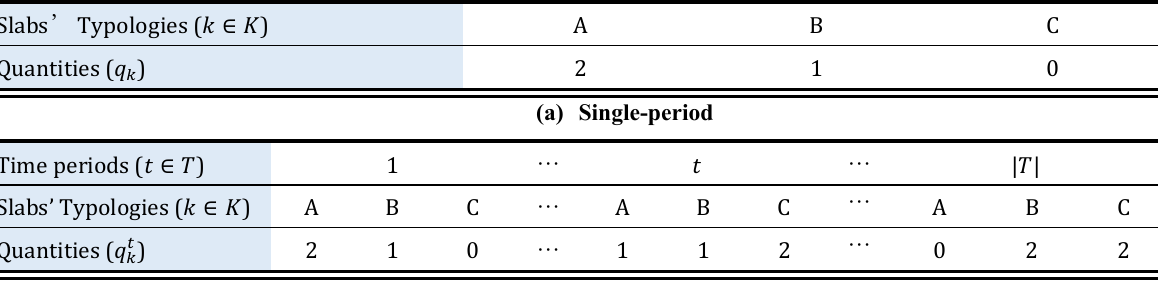
Fig. 4. Examples of (non-sorted) order in cutting